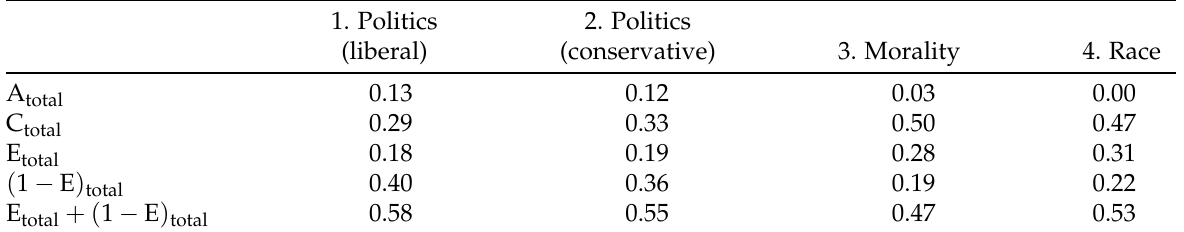
Table 3: Total probabilities of each process across samples 1.